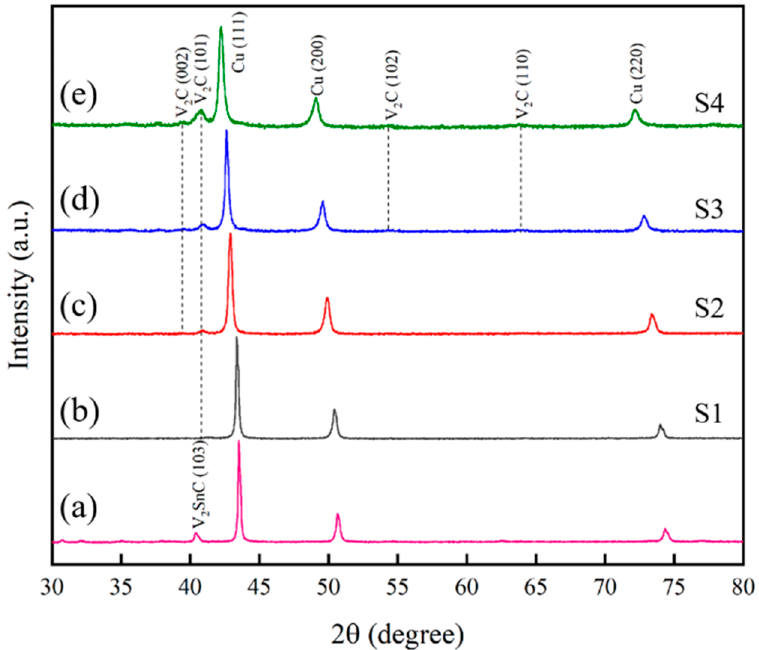
Figure 1. XRD patterns of ( a ) powder mixture and Cu composites with ( b ) 5 vol.% V 2 C, ( c ) 10 vol.% V 2 C, ( d ) 20 vol.% V 2 C, and ( e ) 30 vol.% V 2